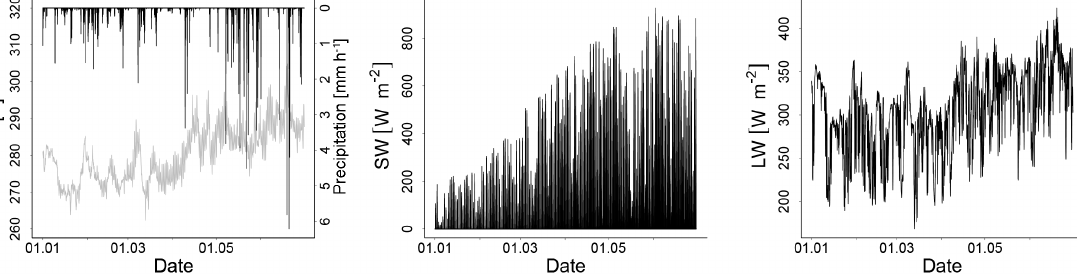
Figure 6. Hourly meteorological forcings for twin experiment from 1 January to 30 June 2013. Left panel shows 2m air temperature and precipitation, middle panel shows incoming short-wave radiation and right panel shows incoming long-wave